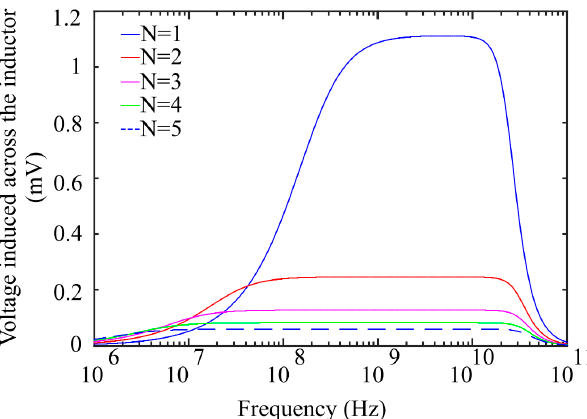
Figure 5. Voltage generated across the loop inductor as a function of number of loop turns . N